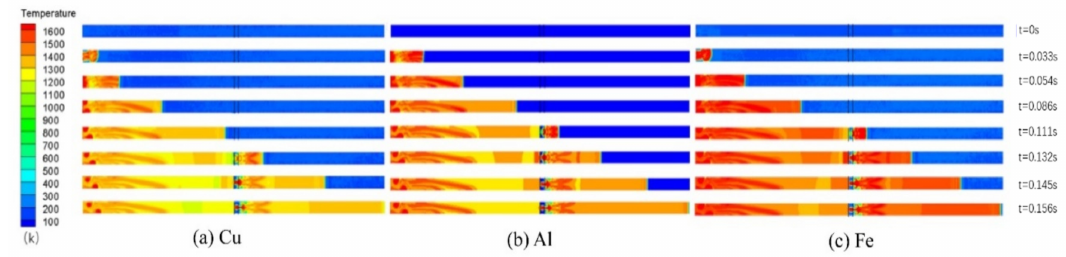
Figure 16. Comparison of temperature cloud of metal foam with different materials.